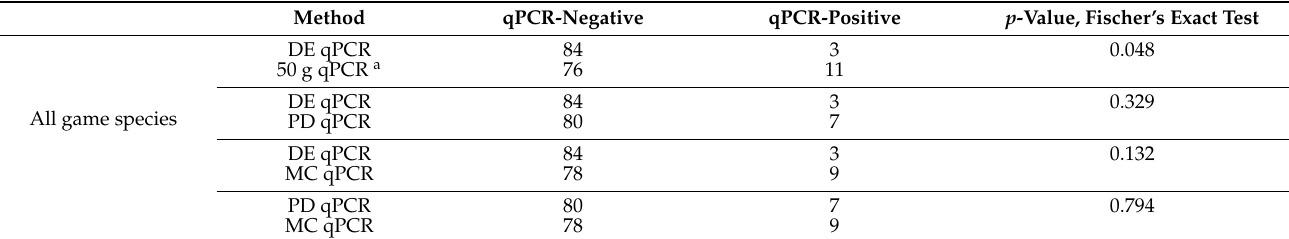
Table 5. Statistical analysis and total summary of qPCR results of all animals analysed by all three direct detection methods ( n =